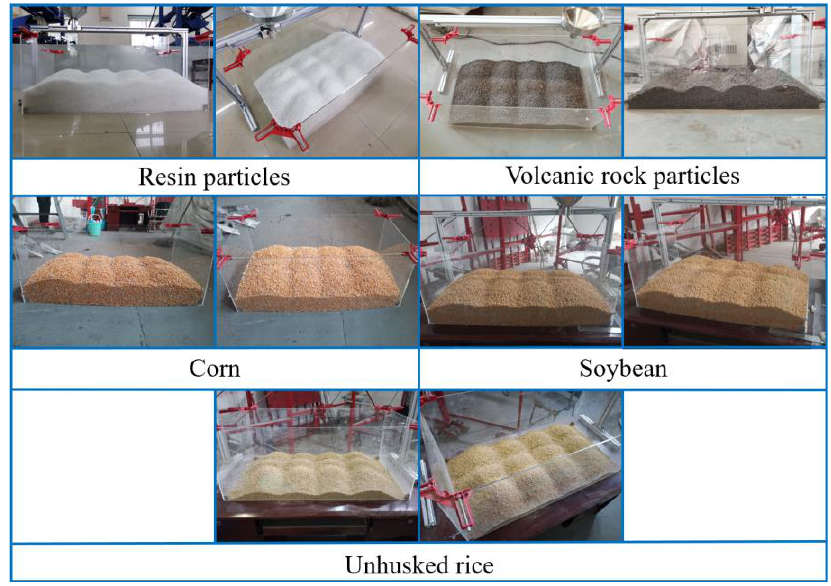
Figure 11. Simulated stacking experiment of different materials.